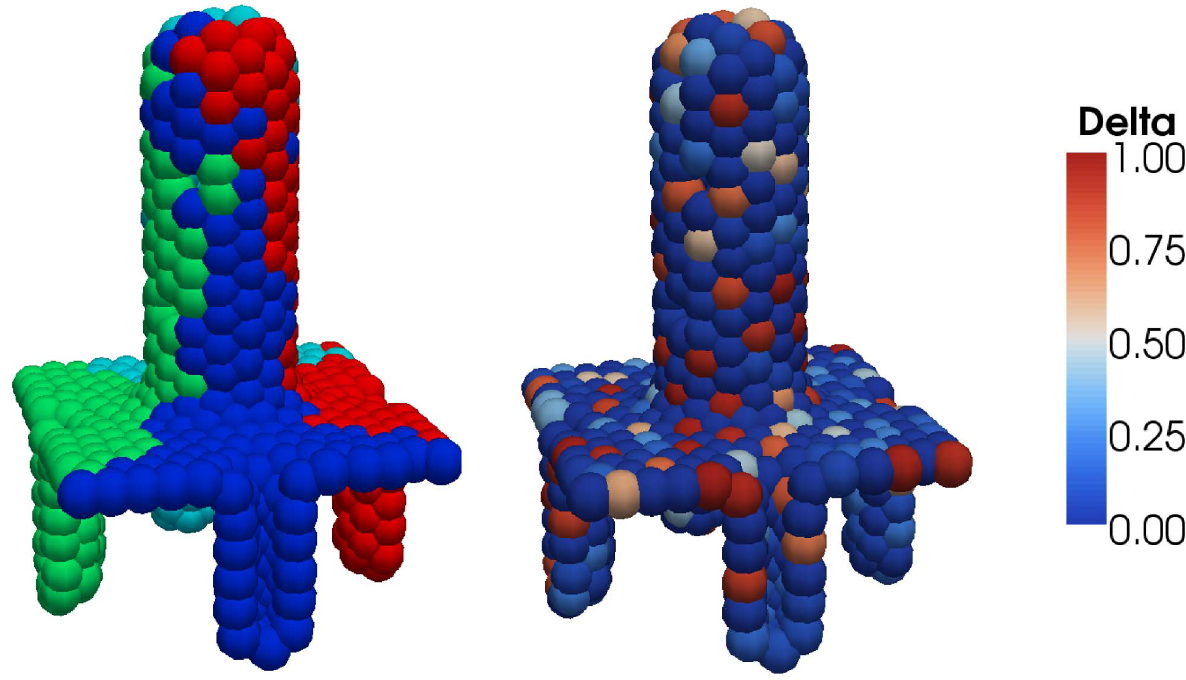
Figure 2. 3D off-lattice simulation confined to a 2D surface: small intestinal crypts and villus. Left: cells are labelled according to their ancestor cell; each crypt gives rise to a monoclonal population, with a multiclonal villus comprised of cells from each crypt. Right: the same simulation, here with cells labelled according to Delta levels (non-dimensionalised); Delta-Notch patterning occurs due to a signalling model inside each cell, which depends on the activity of neighbouring cells, and is thought to lead to differentiation into secretory and absorbative cell types. See also Video S2.